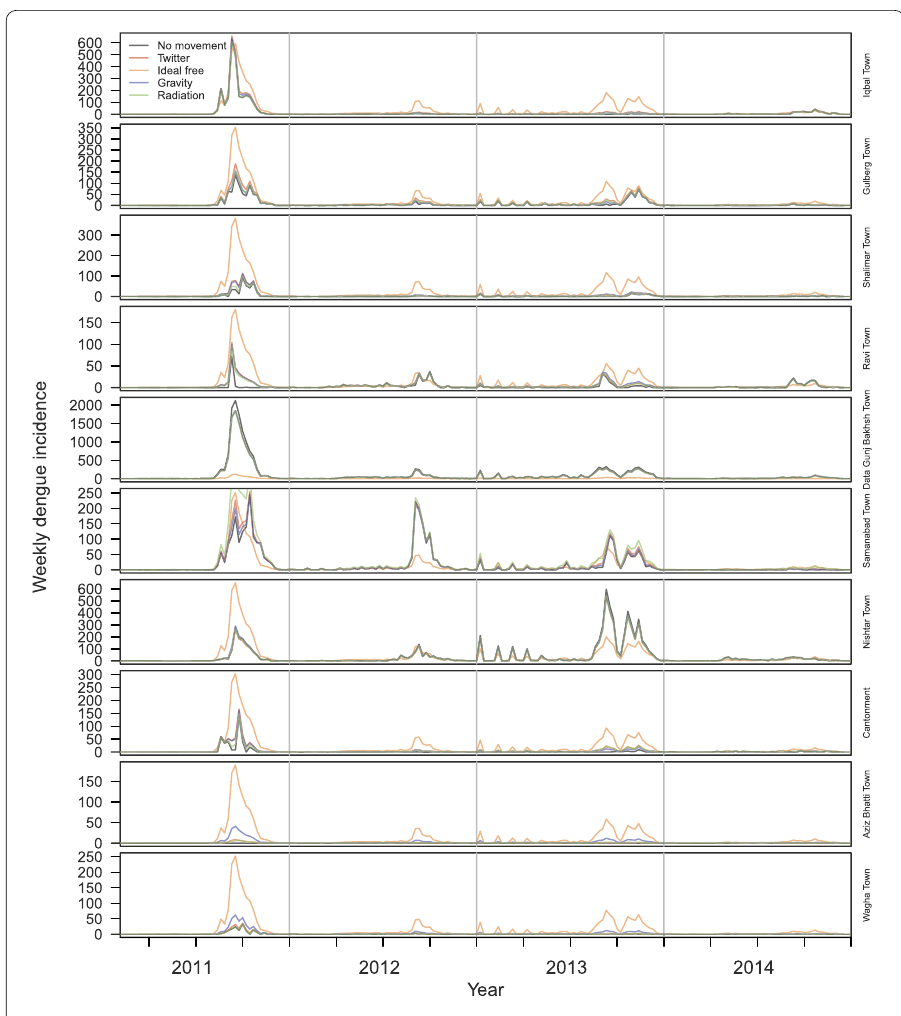
Figure 3 Time series stratified by towns in which cases were assumed to be acquired (rows) under five different assumptions about mobility among towns (line type)